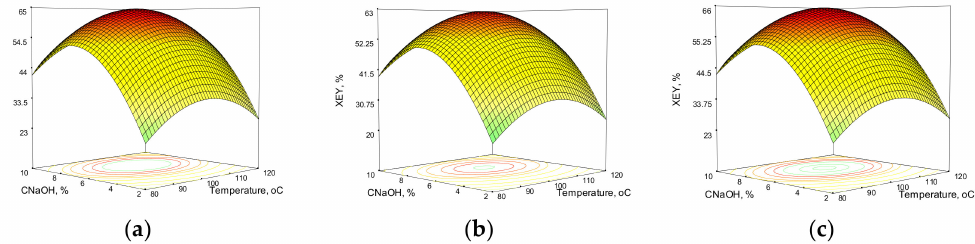
Figure 1. Response surfaces and contour plots of the combined effects of sodium hydroxide con- centration and temperature on xylan extraction yield from wheat straw at various reaction times: ( a ) 60 min; ( b ) 90 min; ( c ) 120 min.